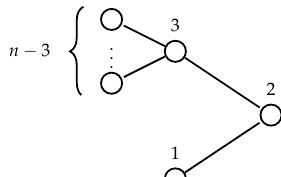
Figure 6. Graph G and valuations v i , j